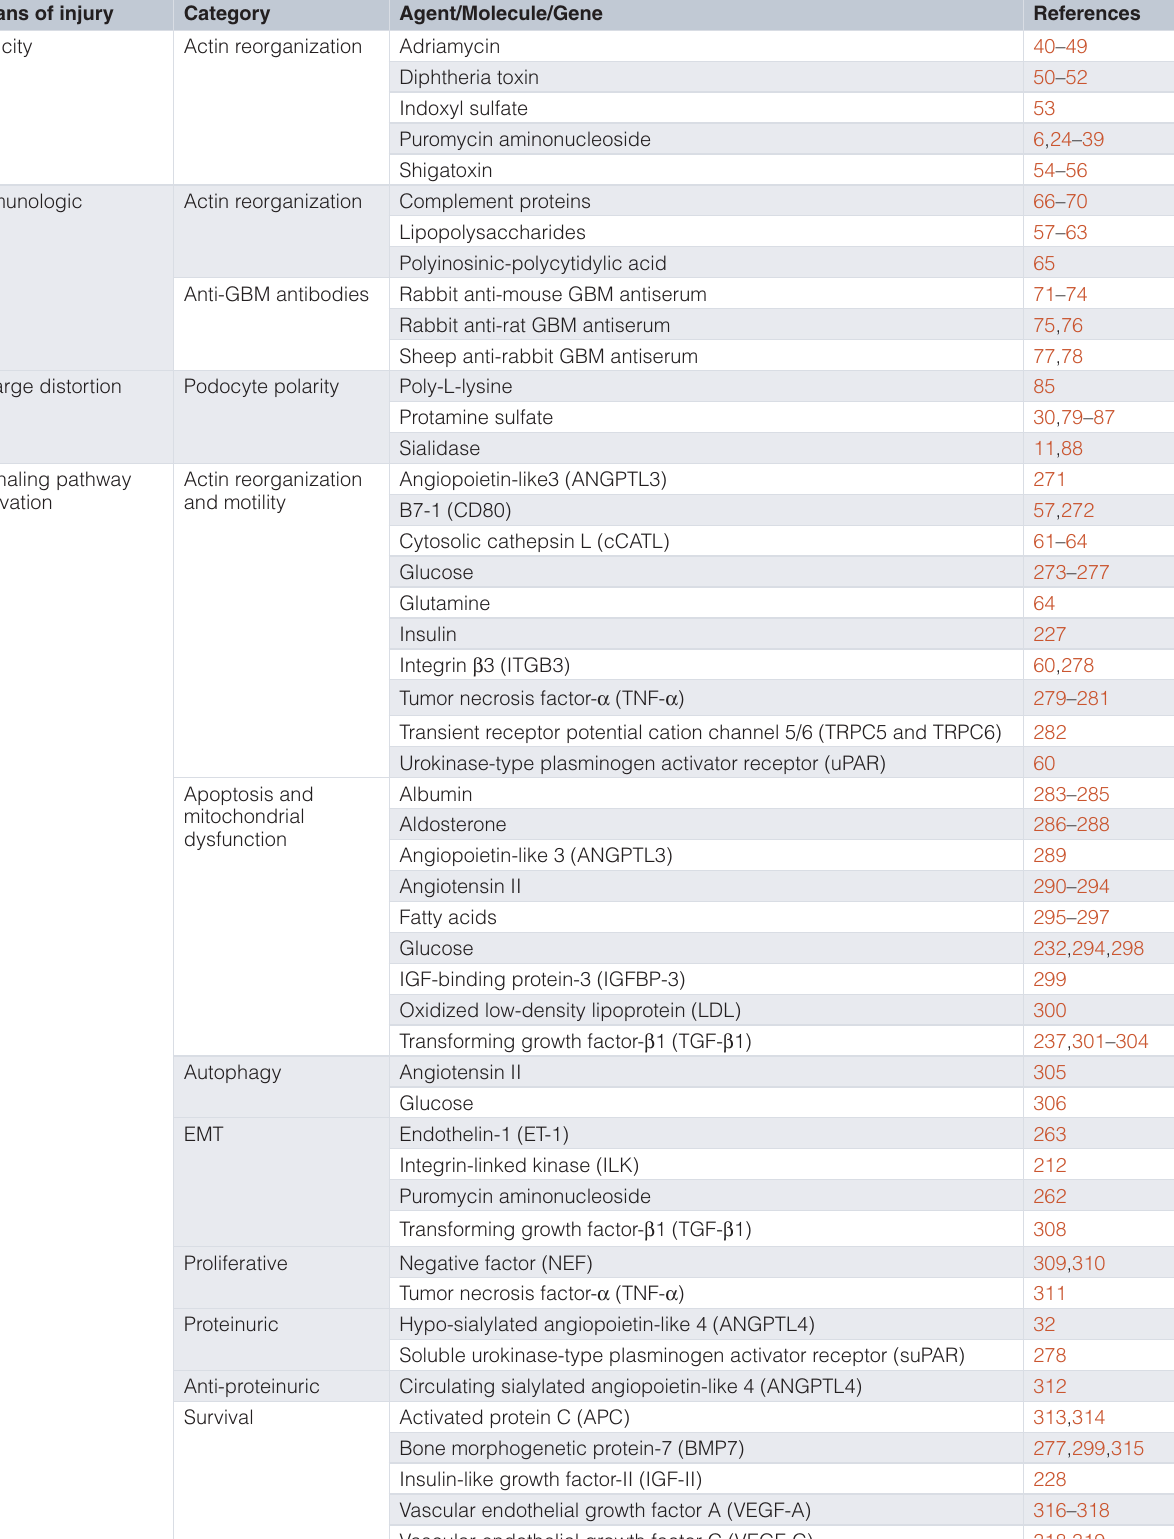
Table 1. Agents, molecules, and genes associated with podocyte injury and foot process